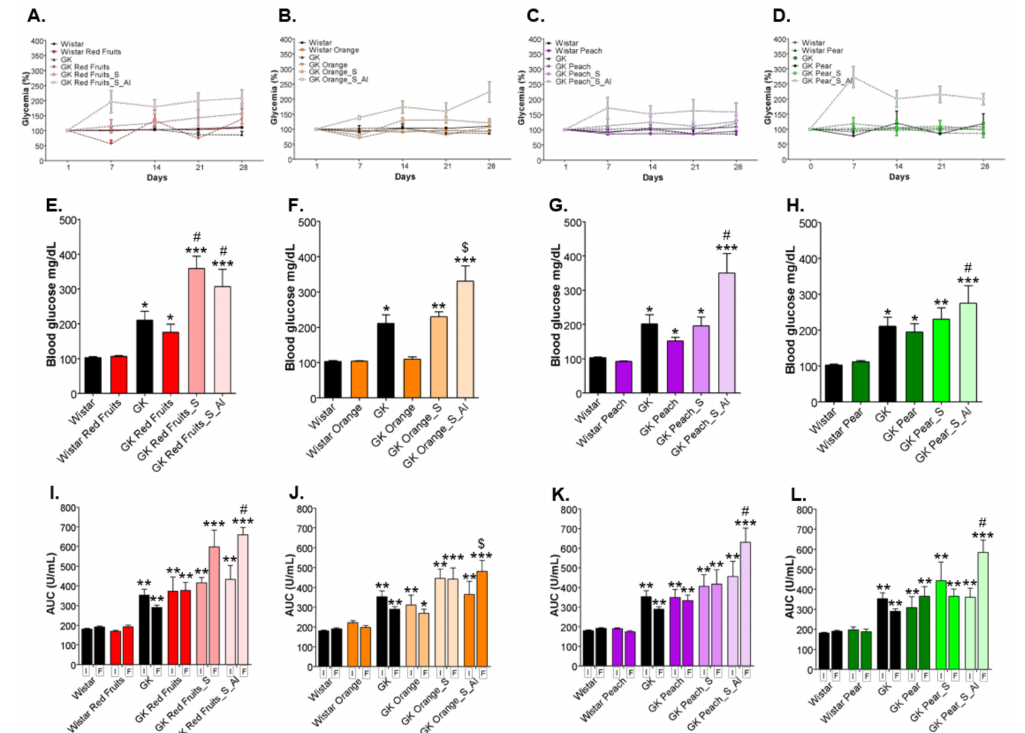
Figure 3. Fasting (6 h) glycaemia was evaluated weekly and calculated the percentage of the initial value ( A – D ). Fasting glycaemia at the end of the treatment is shown in ( E – H ). Before and after the experimental period an i.p. insulin tolerance test was performed and the area under the curve was calculated ( I – L ). * different from Wistar; # different from GK; $ different from GK_Juice. 1 symbol, p < 0.05; 2 symbols, p < 0.01; 3 symbols, p <